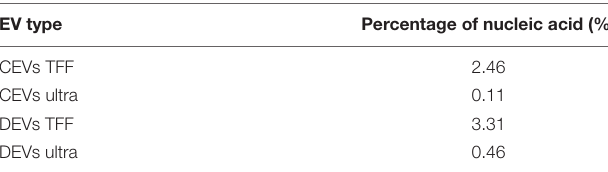
TABLE 1 | The percentage of nucleic acid content in extracellular vesicles derived from chorionic mesenchymal stromal/stem cell (CEVs) and extracellular vesicles derived from decidual mesenchymal stromal/stem cell (DEVs) isolated using tangential flow filtration (TFF) and ultracentrifugation assessed using nano-flow cytometry